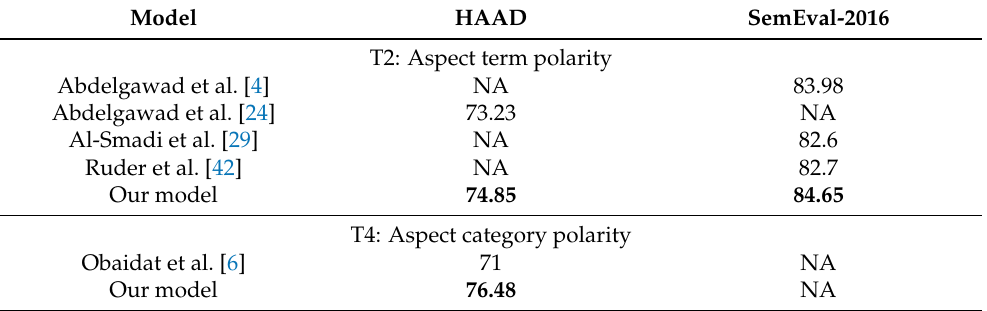
Table 9. Comparison of our best models with previous works. Model